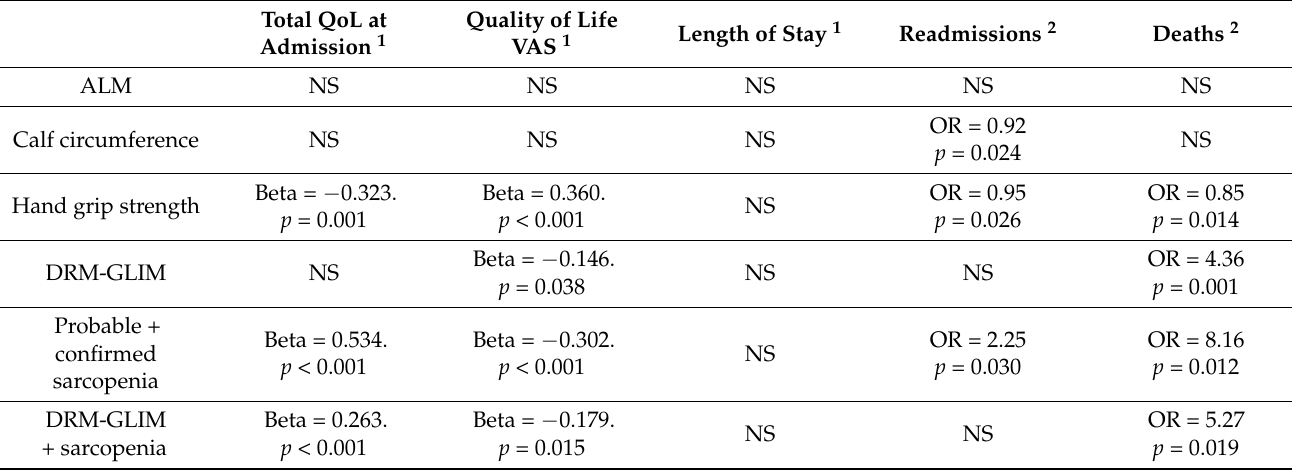
Table 3. Relationships of variables related to low muscle mass/function and a diagnosis of DRM and/or sarcopenia with evolution (length of stay, quality of life, deaths or readmissions) after adjustment for age, sex, and comorbidity. Quality of Life Total QoL at Length of Stay 1 Readmissions 2 Deaths VAS 1 Admission 1